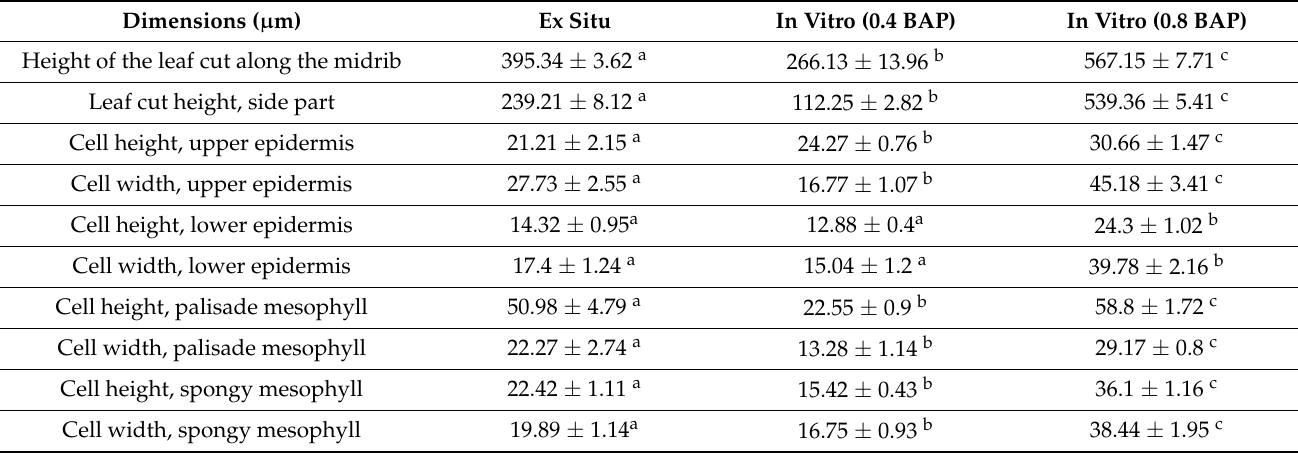
Table 2. Quantitative anatomical dimensions of cross sections of leaf blades of H. officinalis f. cyaneus